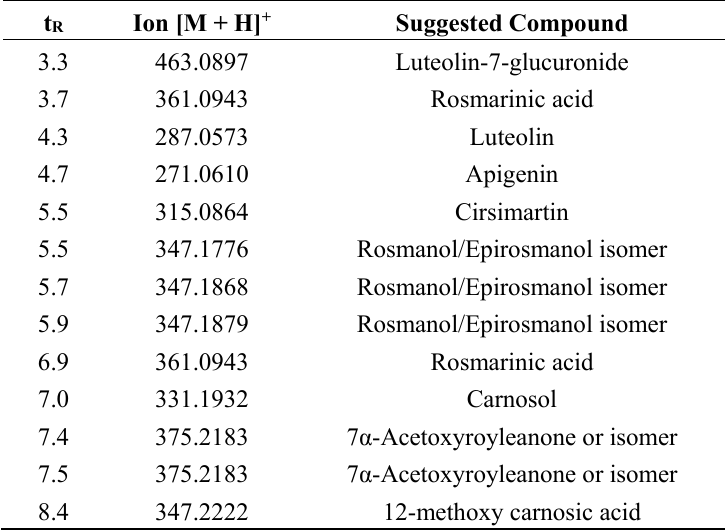
Figure A4. ID_39. Extract of Salvia officinalis L. Table A6. Dereplication results for